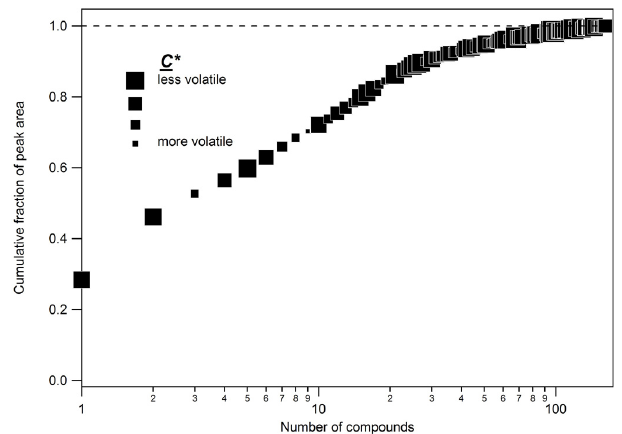
Fig. 8. Number of compounds required to account for a given frac- tion of total peak area. Data from the TAG #3 sample. Marker area is approximately proportional to volatility for each individual